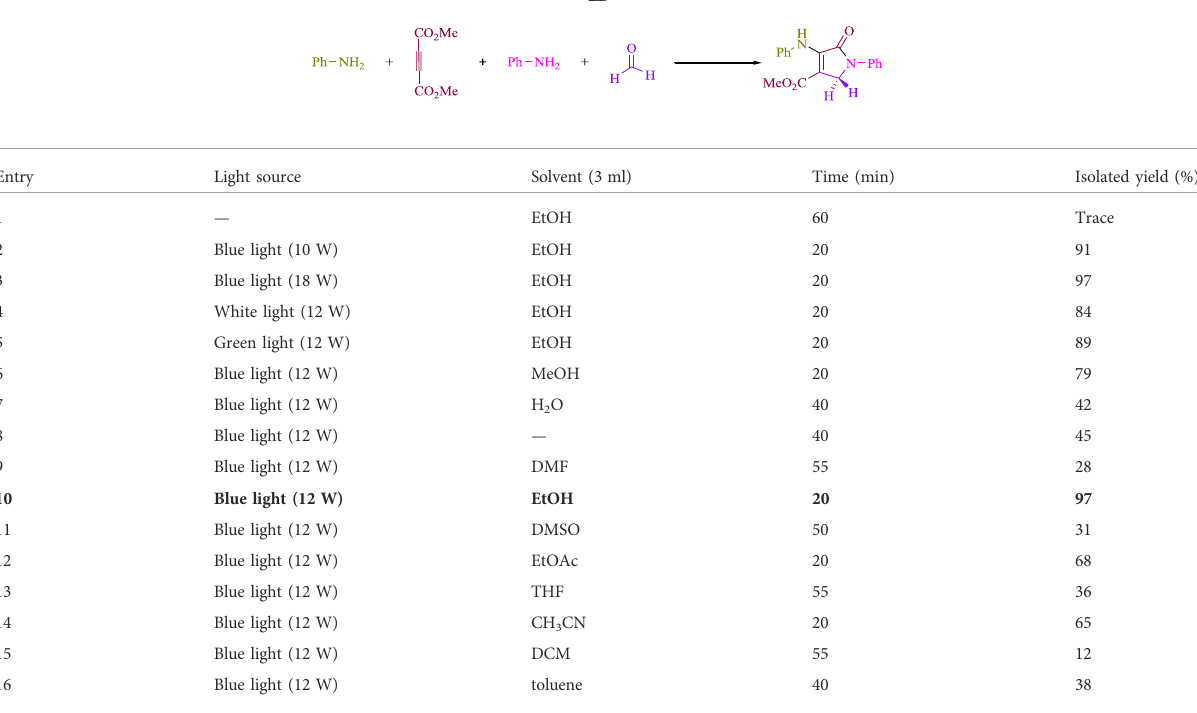
TABLE 2 Table of solvent and visible light optimization is provided for 5a synthesis a